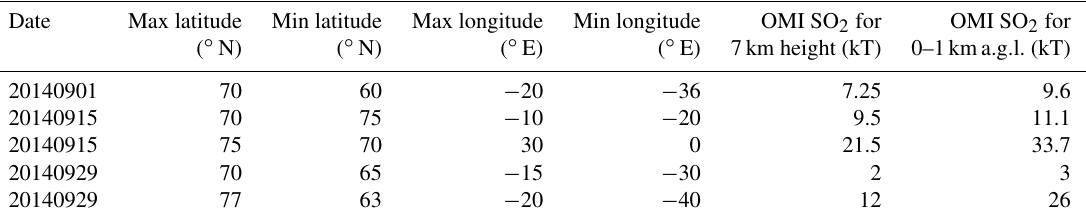
Table 1. Areas of plume missing from IASI detection scheme and OMI SO 2 mass estimate in the area, assuming two different altitudes.